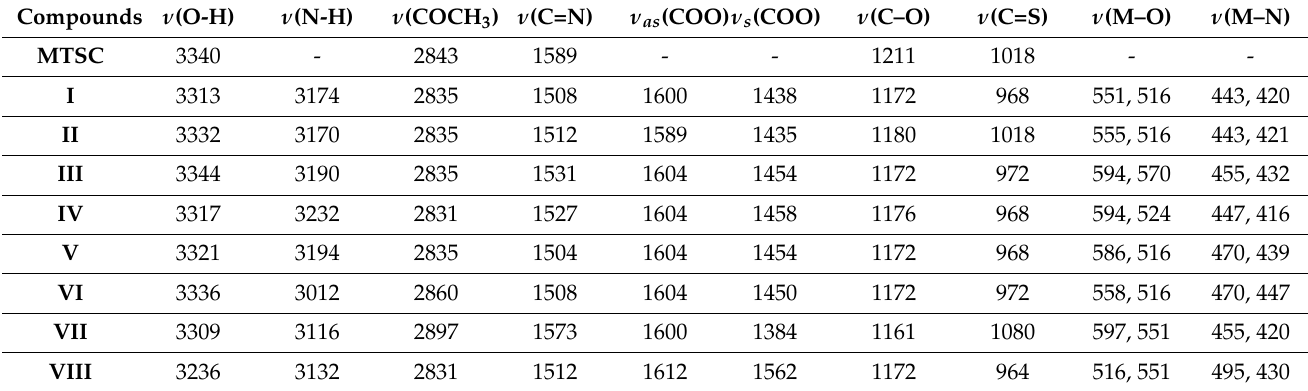
Table 2. IR frequency values (cm − 1 ) for MTSC (free ligand) and its metal